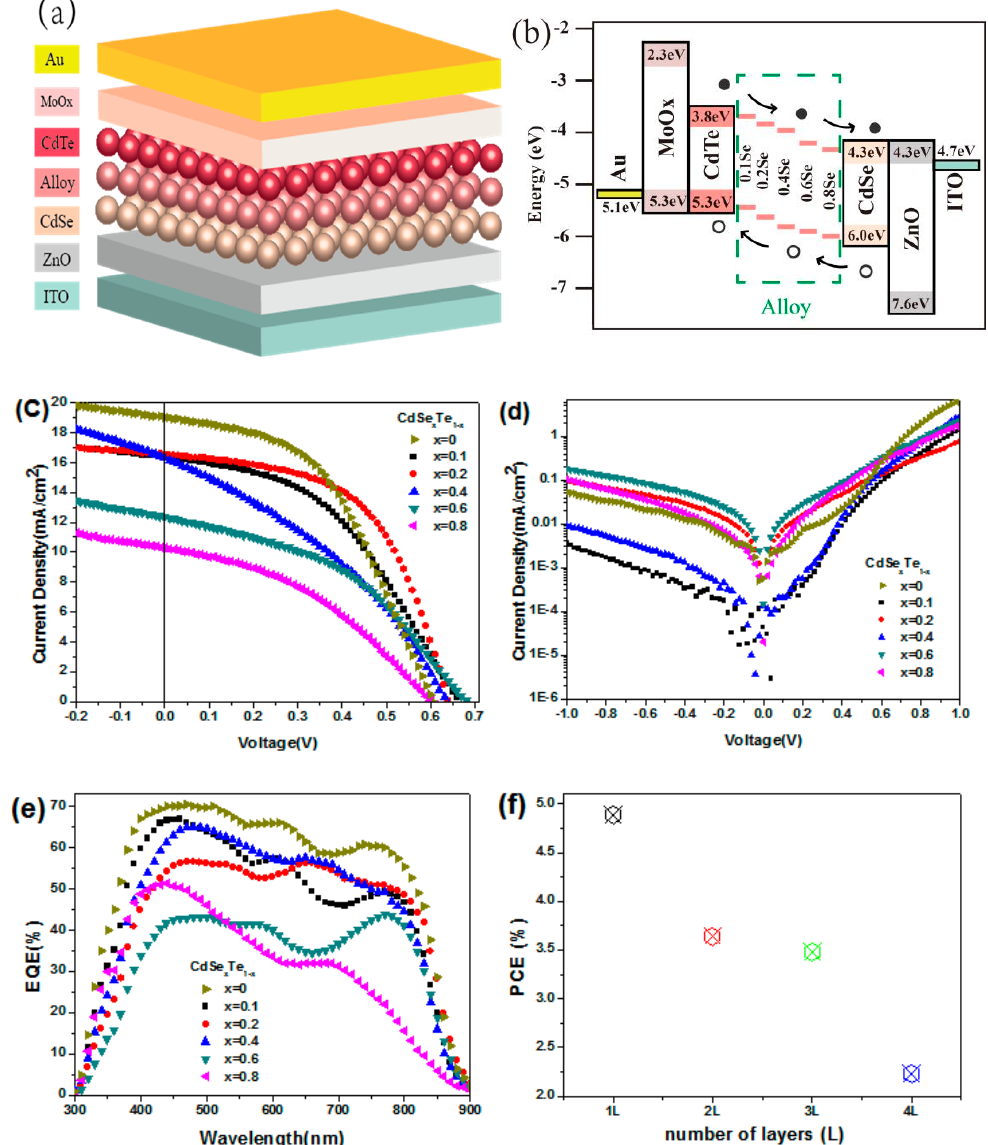
Figure 3. ( a ) Schematic of the vertically-graded bandgap structure of ITO/ZnO/CdSe/CdSe x Te 1- x /CdTe/MoO x /Au, ( b ) energy diagram of the above devices, J - V characteristics of the above devices ( c ) under light and ( d ) dark, ( e ) EQE properties of the devices, and ( f ) the PCE of NC solar cells with different thickness of CdSe 0.2 Te 0.8 alloy NC films [64].